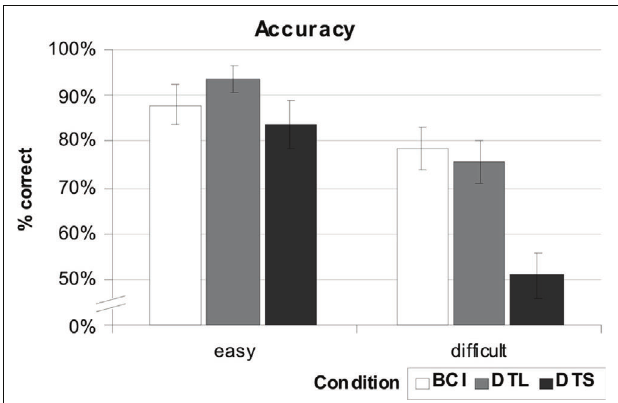
FIGURE 8 | For condition “easy”, accuracy of the BCI based solution was only slightly lower (88%) compared to the long dwell times (DTL, 93%). Short dwell times (DTS) resulted in the lowest mean accuracy (83.3%). Remarkably, the BCI achieves the best results in accuracy for the condition “diffi cult” (78.7%), but only the difference to the short dwell time (51.1%) was signifi cant. 1 We thank Christian Kothe and Matti Gaertner (Team PhyPA) and Roman Vilimek